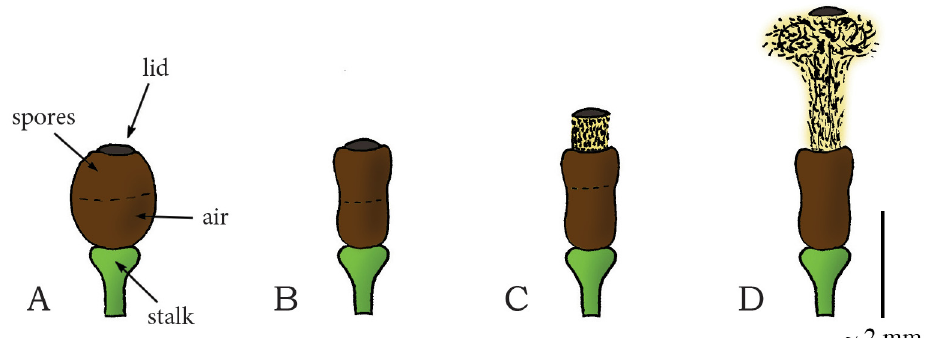
Fig 18. Air pressure catapult mechanism in the genus Sphagnum . (A) The mature spherical spore capsule of Sphagnum filled with spores and air (equal portions). (B) Deformation of the capsule into cylindrical shape due to drying, which raises the air pressure in the capsule. (C – D) When a critical pressure is reached, sudden fraction of the capsule lid explosively discharges the spores from the capsule. Drawings based on schematic drawings in [1]. Scale bar 2